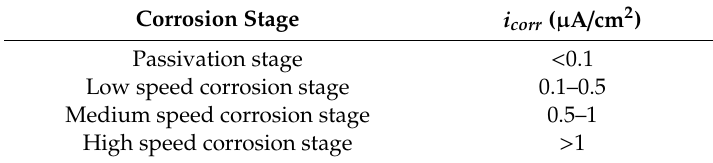
Table 4. Recommended standard for corrosion current density of reinforcement in concrete [47].